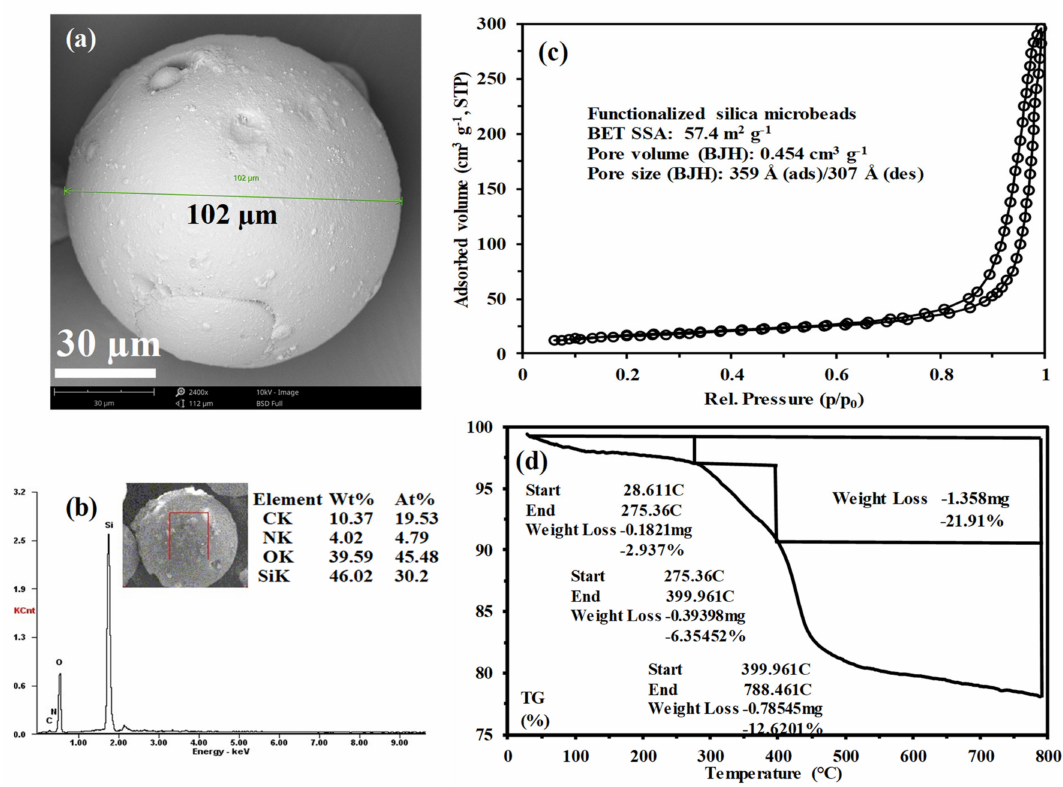
Figure 1. Characterization of functionalized sorbent: ( a ) SEM micrograph, ( b ) semi-quantitative EDX analysis of sorbent surface, ( c ) BET analysis of silica beads and silica microbeads (sorbent), and ( d ) TGA analysis of